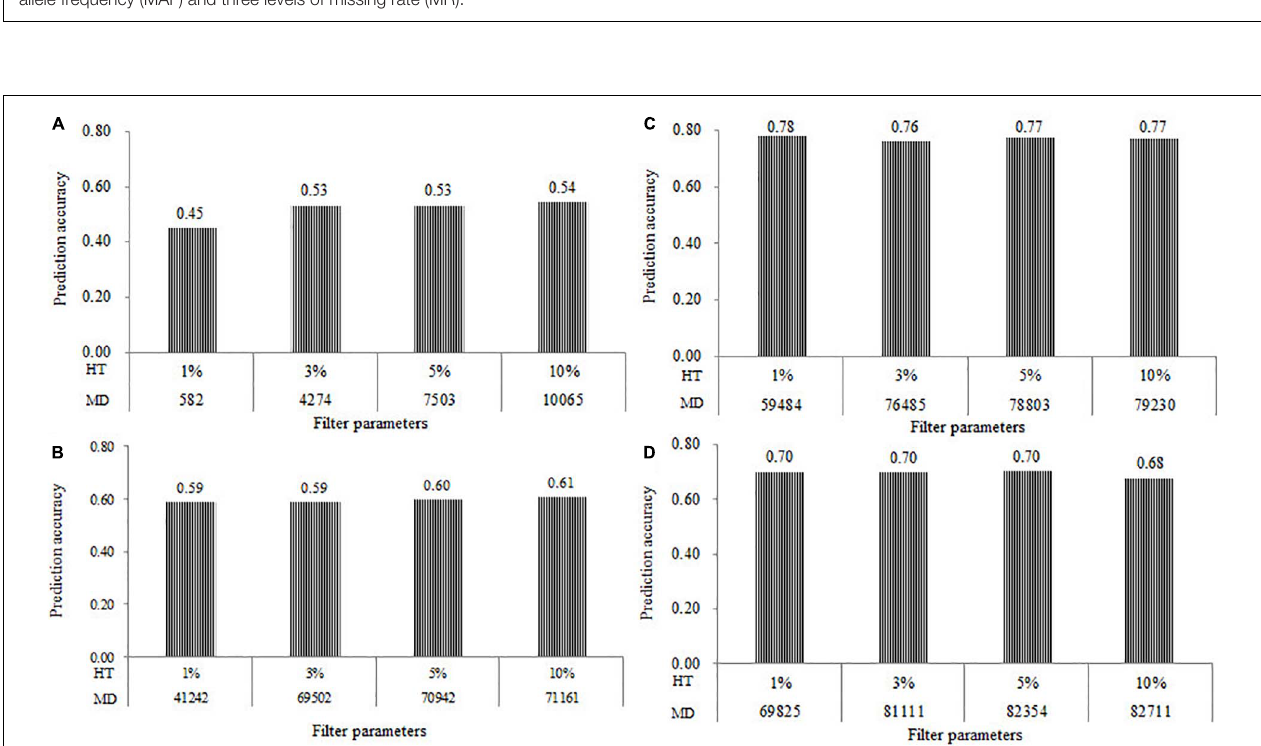
FIGURE 2 | Genomic prediction accuracies for TSC resistance estimated from the five-fold cross-validation scheme in all the four populations of (A) DTMA association mapping panel, (B) Pop1, (C) Pop2, and (D) Pop3, under the nine levels of marker density (MD) filtered with the combinations of three levels of minor allele frequency (MAF) and three levels of missing rate (MR).